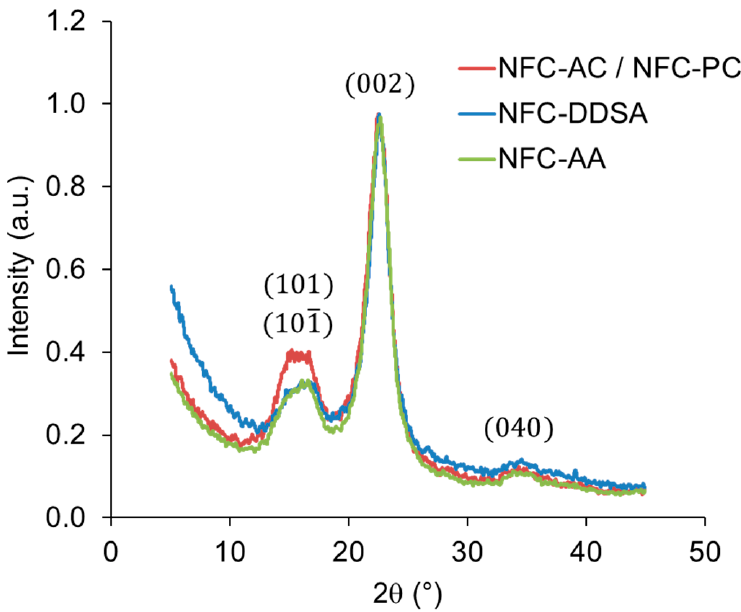
Figure 3. X-ray diffractograms of unmodified NFC (NFC-PC/NFC) compared to NFC modified with acetic anhydride (NFC-AA) and (2-dodecen-1-yl)succinic anhydride (NFC-DDSA) for 24 h.